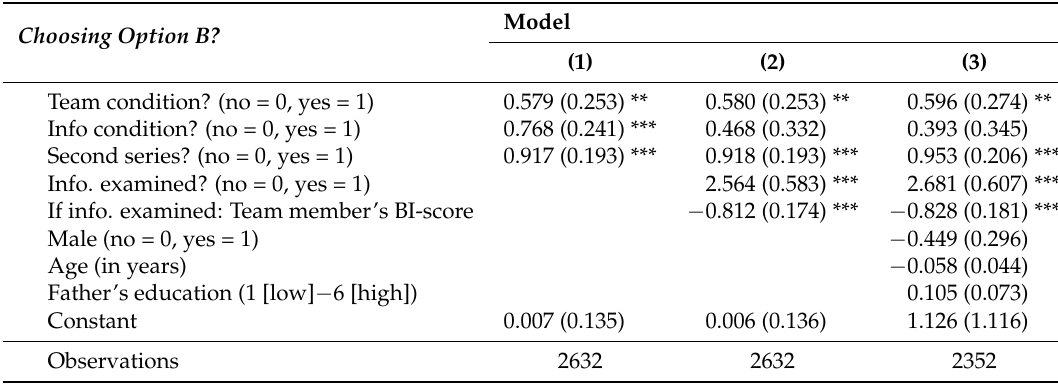
Table 3. Random effects logit regressions of B-choices in both race